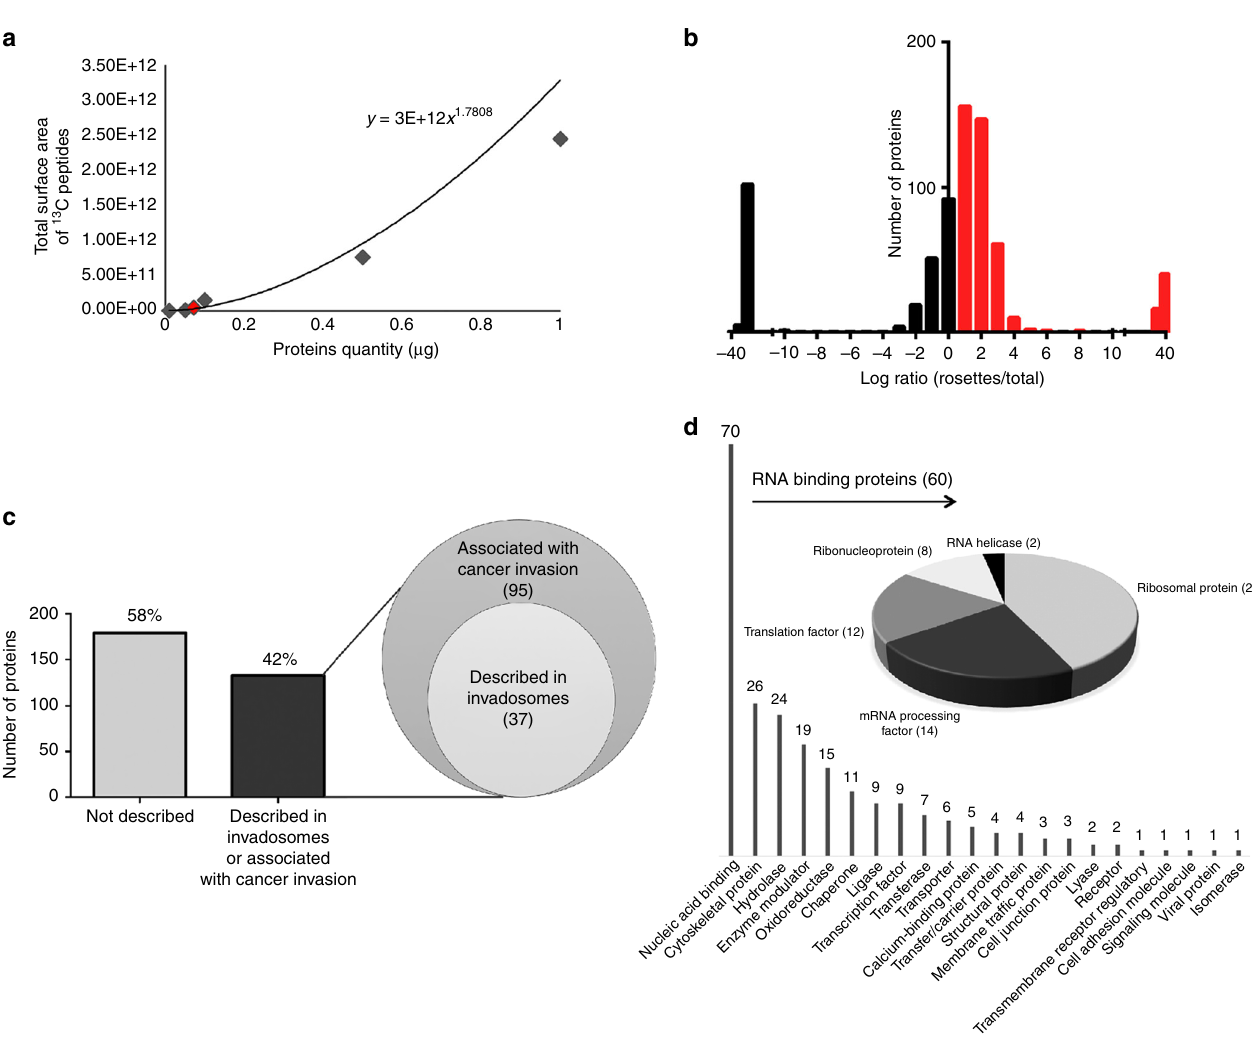
Fig. 2 Enrichment analysis and functional classi fi cation of proteins. a The closest point of the total protein quantity range (100 ng) was chosen to compare the MS relative abundances after normalisation. b Among the 366 proteins identi fi ed with at least 2 peptides in the rosettes sample, 312 proteins were enriched with a rosette/total proteome abundance ratio ≥ 1.5 (log ratio ≥ 0.6 in red). c Manual sorting of the proteins according to their characterization in the literature. Among the 312 enriched proteins, 42% (95 proteins) were associated to cancer invasion including 37 proteins already described in the invadosomes. d The bart chart represents the classi fi cation of the 312 enriched proteins according to the GO categories ( “ Protein class ” classi fi cation from the PANTHER database). Among the 70 nucleic acid proteins, 60 proteins were sub-classi fi ed as RNA-binding proteins whose functional assignments distribution is represented into the pie